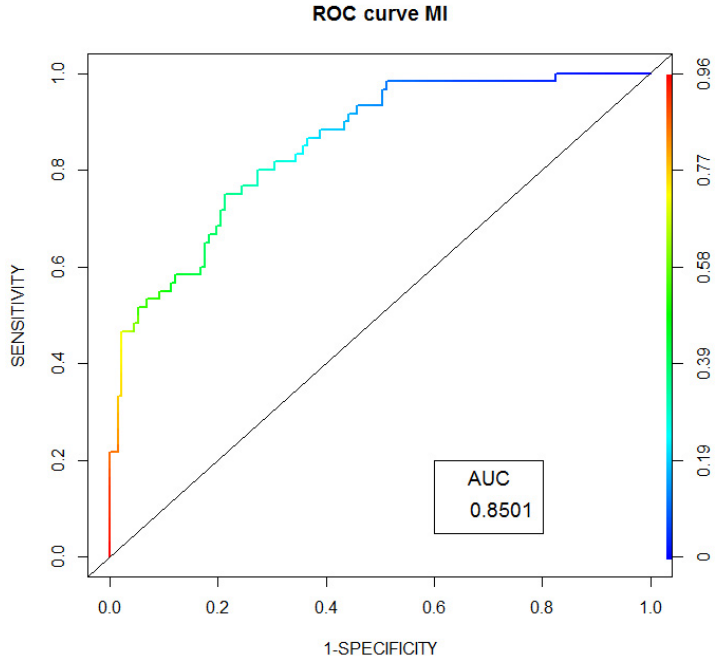
Figure 2. ROC curve of prognostic model of MI outcome in FH patients. The combined end point (CEP) included MI, unstable angina, and ischemic stroke. Non-lipid risk factors in patients with CP and FH are presented in Table 7; the lipid factors are presented in Table 8.